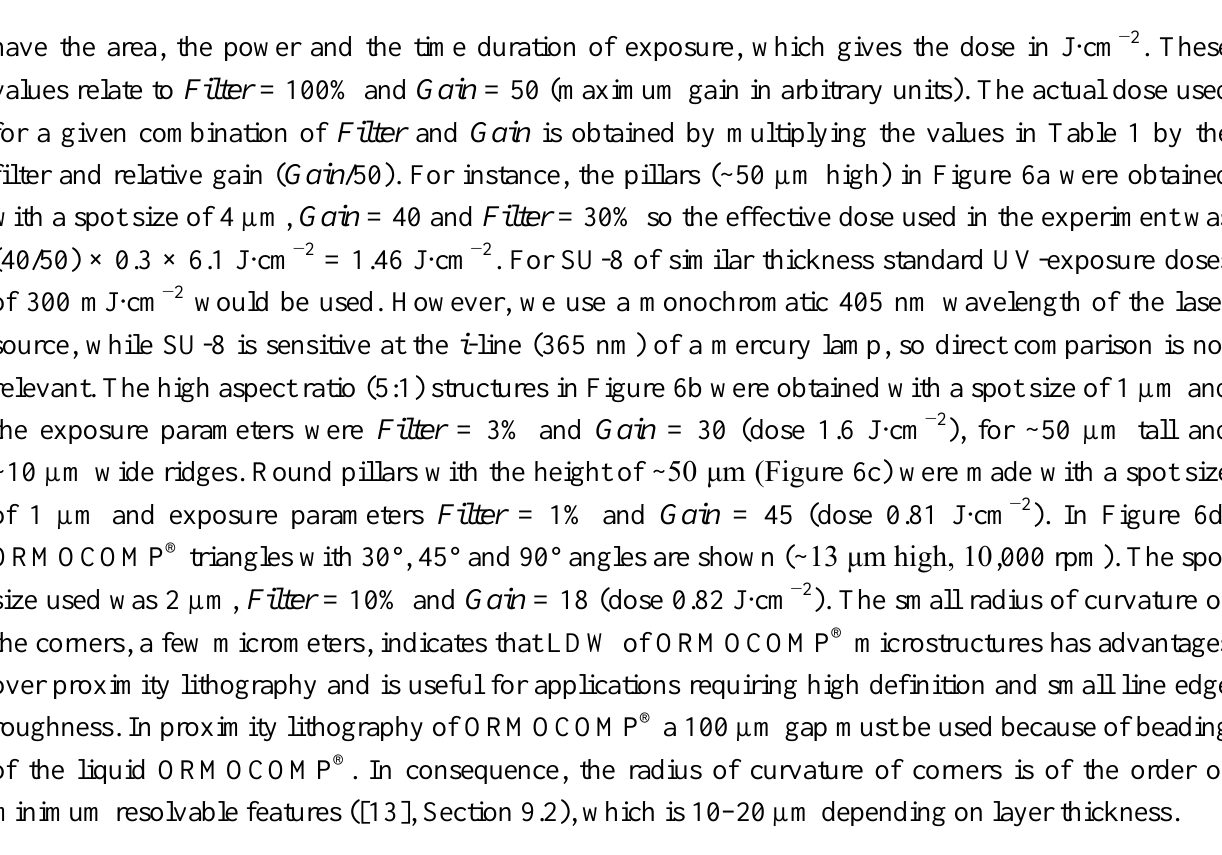
Table 1. Effective dose calculated for each laser spot diameter, with non-overlap RNO = 0.2, Gain = 50 and Filter = 100